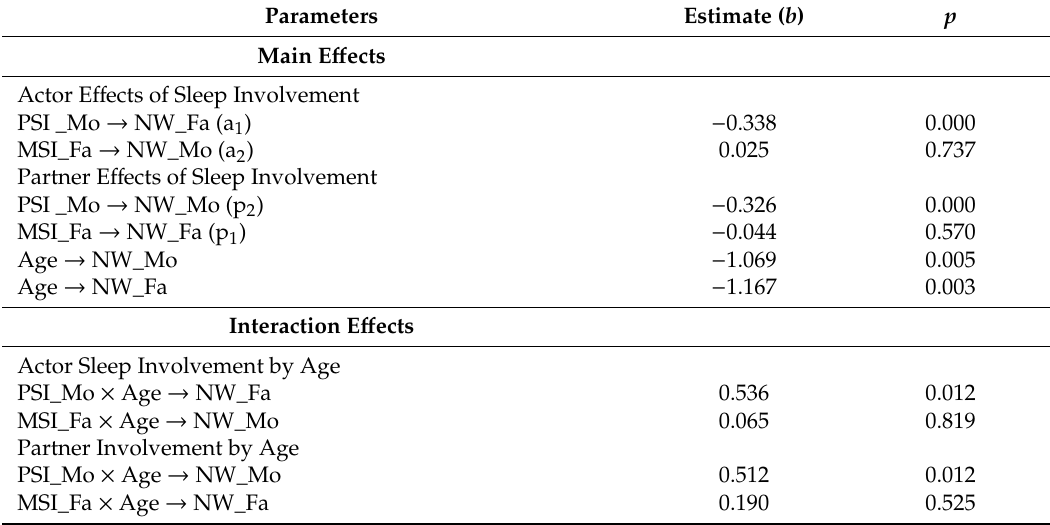
Table 2. APIM results: Associations between paternal and maternal involvement in children’s sleep care with the number of night awakenings with the moderating context of